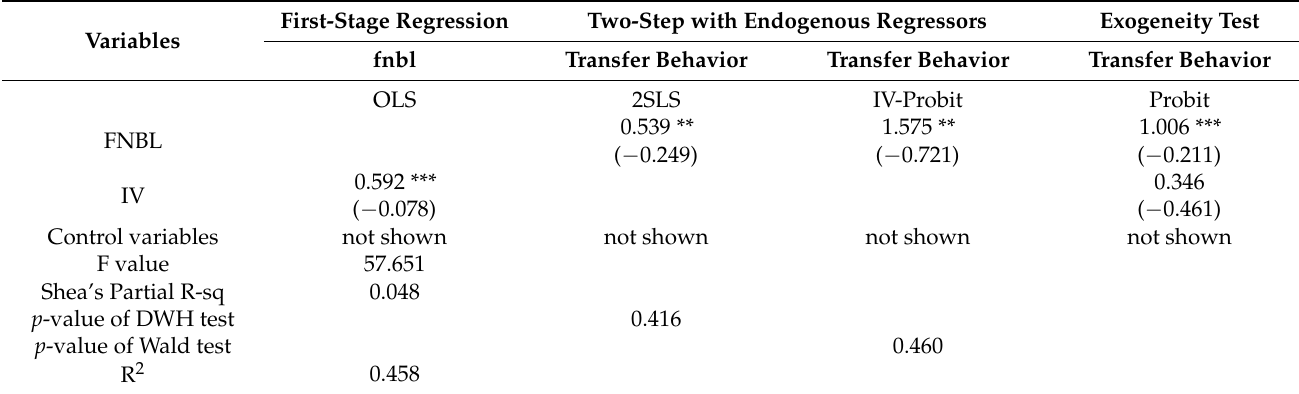
Table 2. Endogeneity test results based on instrumental